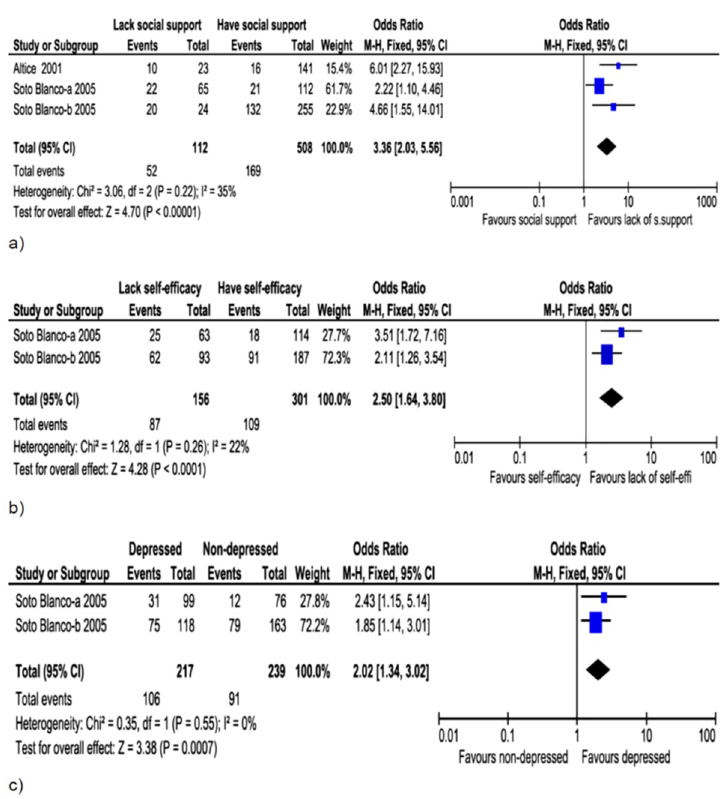
Fig 3. Forest plot of associations between non-adherence and social support (a), self-efficacy (b) and depression (c). Inmates who lacked social support, were unable to consistently use ART (or lacked self-efficacy) and those with experience of depression were less likely to be adherent to